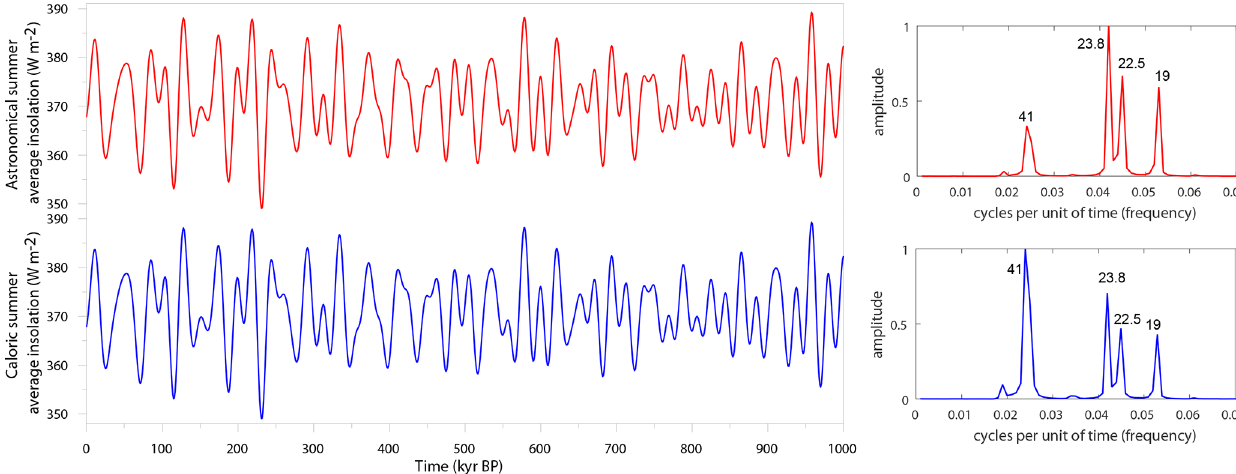
Figure 1. Average insolation of the half-year astronomical (red) and caloric (blue) summer seasons and their spectra (based on Berger and Loutre, 1991; Berger et al., 2010). The major periodicities are indicated in thousands of